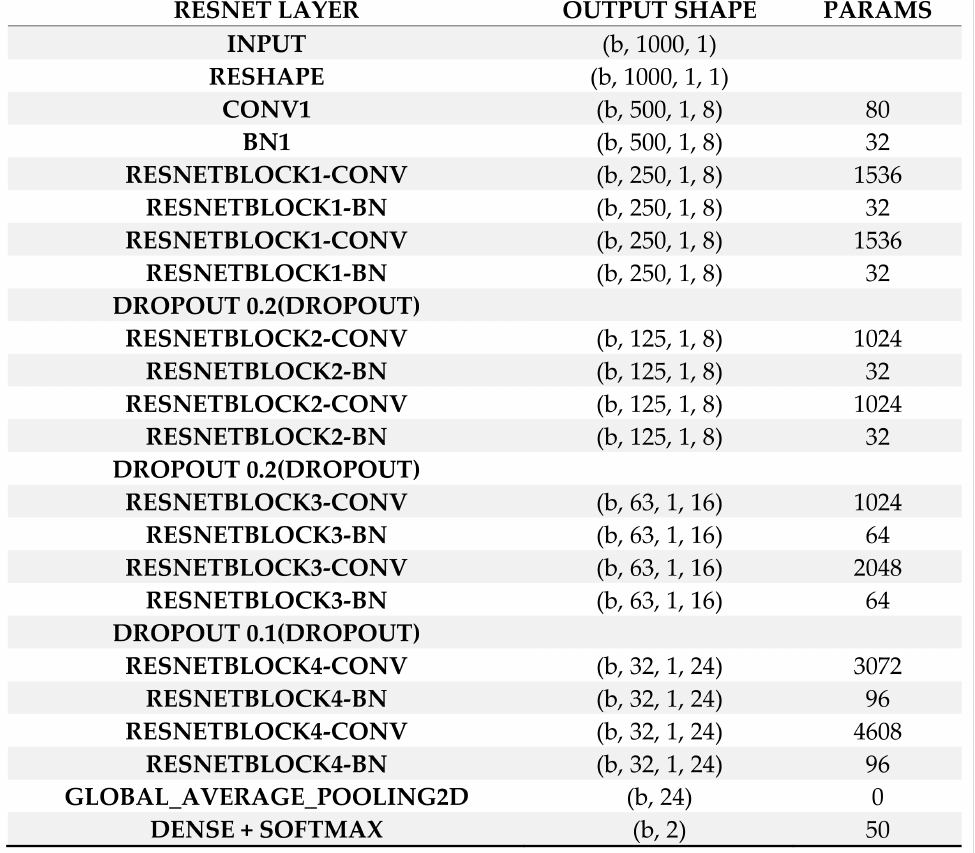
Figure 2. Resnet Architecture. Note: BN Batch Normalization, CONV Convolution, PARAMS Parameters. Specifically, a certain type of deep learning models, so-called convolutional neural networks, have emerged as dominant deep learning models in the past decade. The con- volutional neural network has convolutional layers, in which a kernel passes across input data and performs “convolution”, that is, computes the dot product of its own elements and their input-data counterparts. The operation of convolution helps the convolutional neural network to detect specific characteristics of the input data, e.g., the form of a normal rhythm vs. its arrhythmia counterpart. However, the convolutional neural network has an issue of gradient vanishing: As it becomes deeper (the number of its layers increases), the gradient of the loss with respect to the weight becomes 0 quickly. In this context, it has been an important task for deep learning experts to develop a new deep learning model, which manages its considerable depth (e.g., 100 layers) and unprecedented performance at the same time